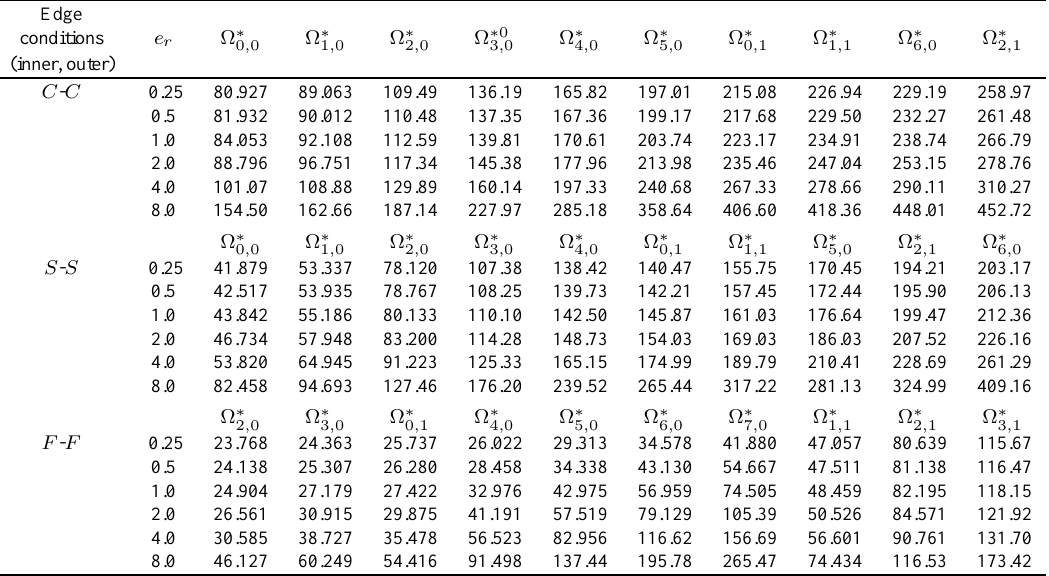
Table 6 Variation in Ω ∗ m,n with e r for C - C , S - S and F - F plates when α = β = 0 . 4 ,g r = 5 . 0 , R 0 = 0 . 5 ,K f = 500